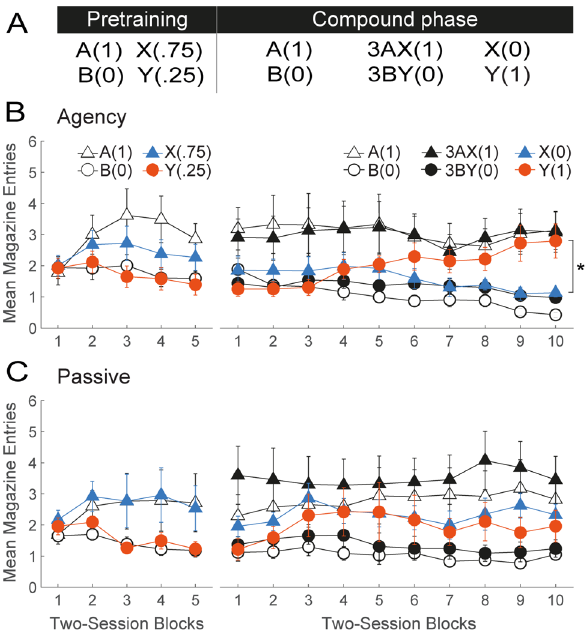
Figure 2. Agency over learning rescues competitive credit assignment from the deleterious effects of massed training in a novel cue-competition task. ( A ) Experimental design. The coefficient 3 denotes three times as many presentations of the AX(1) and BY(0) compounds as of the rest of trial types. During the Pretraining phase, all rats received discrimination training between A and B and X and Y. In the Compound phase, these stimuli continued to be presented with the same probability of reward. However, X was presented in compound with A on the 75% of trials in which it was rewarded (allowing A to take away its credit), whereas Y was presented in compound with B on the 75% of trials in which it was not rewarded (allowing B to take the blame for reward omission). Trials with X(0) and Y(1) permitted continual monitoring of the predictive status of these stimuli as the discrimination developed. ( B , C ) Behavioral results in groups Agency and Passive, respectively. The left and right line plots depict performance during the Pretraining and Compound phases, respectively. Conditioned responding is represented as mean number of magazine head entries (±